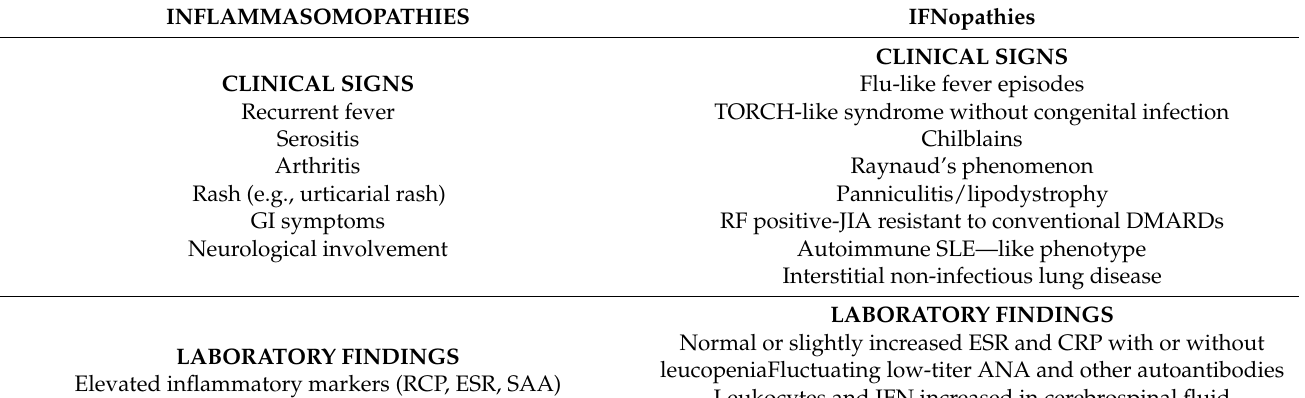
Table 5. Inflammasomopathies versus